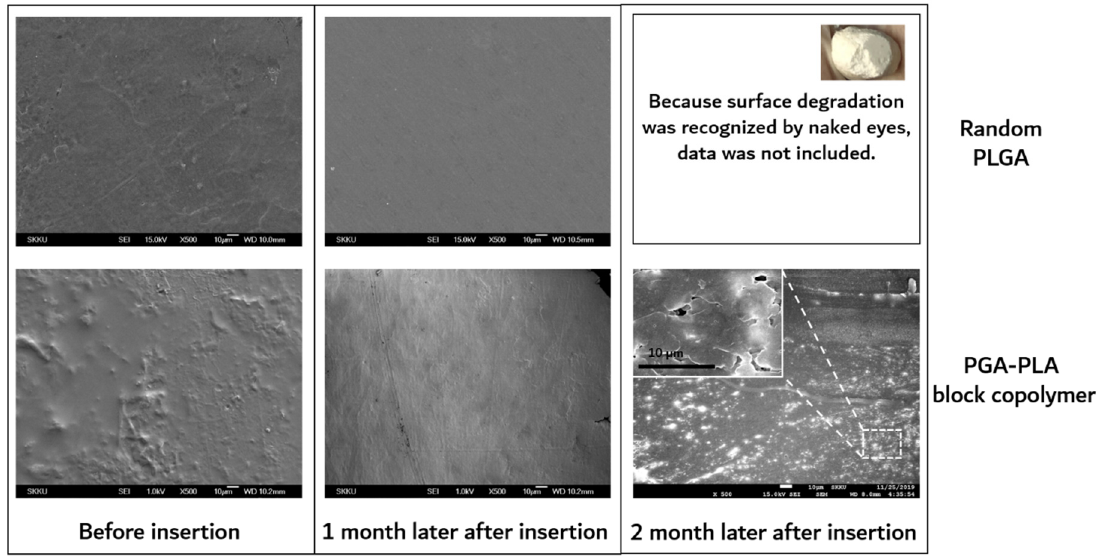
Figure 9. SEM images of surfaces of extracted samples, which were harvested after 0 to 2 months’ insertion.